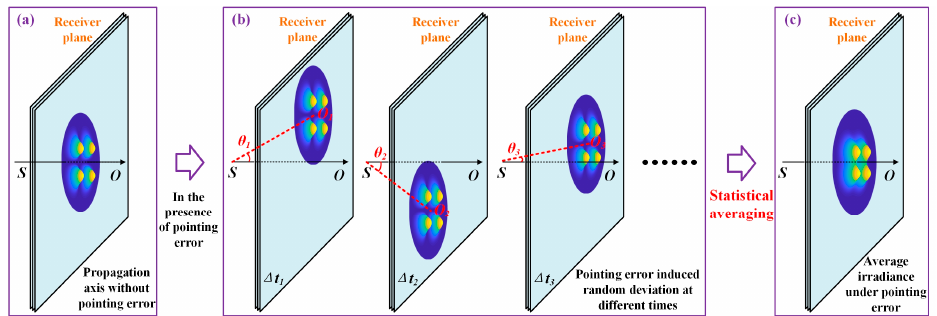
Figure 1. Forming process of average irradiance of HG beam under pointing error. (a) Propagation axis without pointing error, (b) Pointing error induced random deviation at different times, (c) Average irradiance under pointing error.